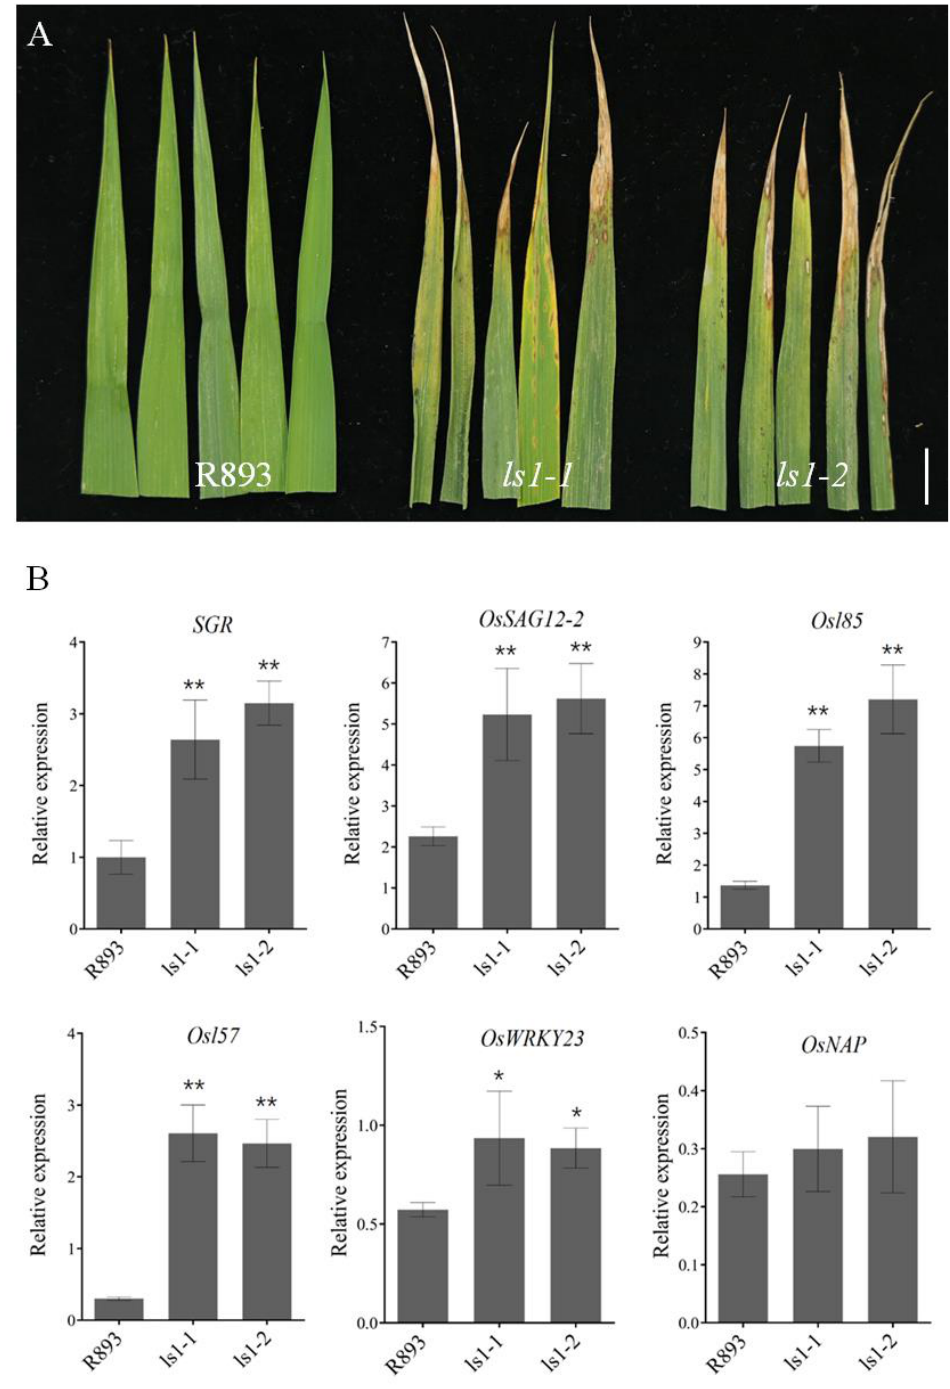
Figure 3. Leaf upper phenotype in ls1 plants at the heading stage and expression levels of SAGs. ( A ) Leaf phenotype of WT and ls1 mutants at the heading stage. ( B ) Transcript levels of six SAGs were analyzed using RT-qPCR. The error bars indicate SDs of three biological replicates. The p -value was calculated using a Student’s t -test. ** p < 0.01, * 0.01 < p < 0.05. Bar = 2 cm ( A ).